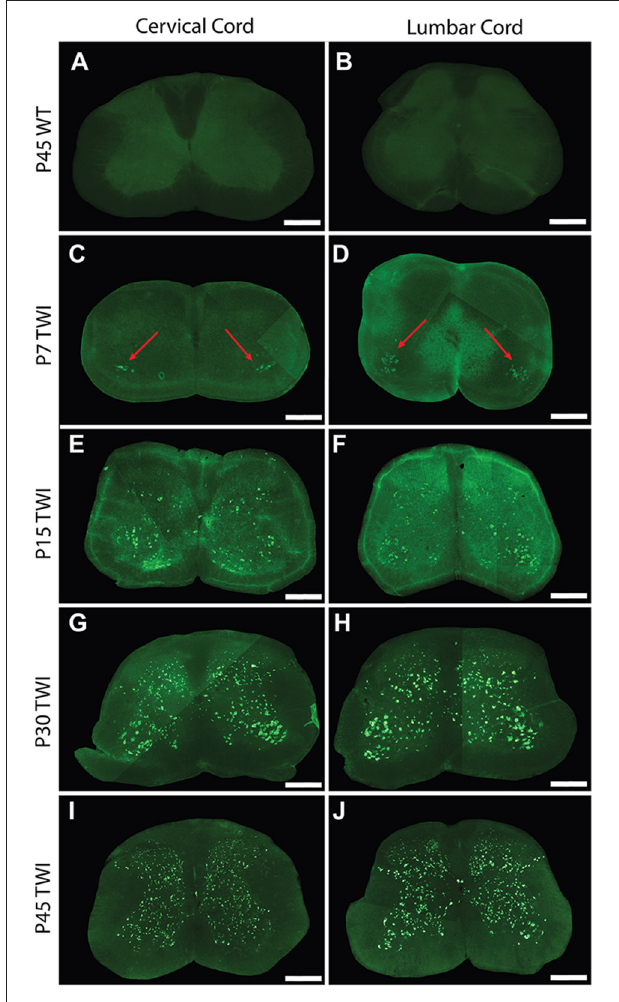
FIGURE 1 | Thioflavin-S accumulation in spinal cord across life span. Spinal sections from the cervical cord of post-natal day 7 (P7) (C) , P15 (E) , P30 (G) , and P45 (I) twitcher mice were stained with thioflavin-S (thio-S) to reveal presence of protein inclusions. There is a progressive accumulation across lifespan with the earliest detection at P7 primarily present only in the ventral horn ( C, red arrows ). A similar pattern of accumulation was noted within the lumbar horns at the same time-points P7 ( D, red arrows ), P15 (F) , P30 (H) , and P45 (J) . Cervical (A) and lumbar (B) spinal sections from a P45 wild type (WT) mouse reveal the background staining and confirm a lack of thio-S reactive material. Images depicted are representative of the thio-S inclusion burden within the cervical and lumbar regions of the spine. They do not represent a precise spinal level. Scale bars represent